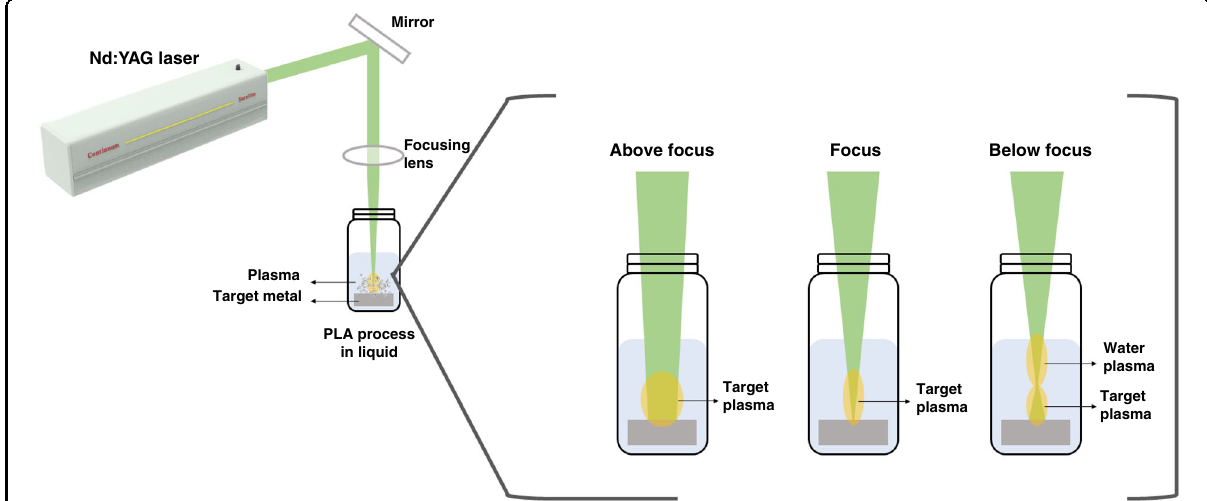
Fig. 4 Schematic illustration view of the PLA process in liquid medium with various target positions: above-focus, at-focus, and below-focus conditions